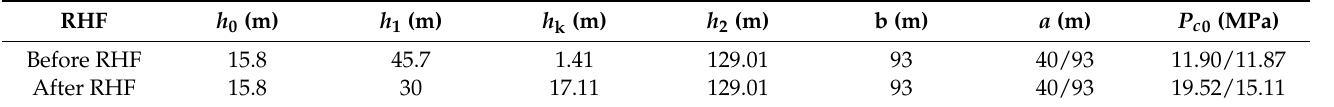
Table 3. Critical water pressure before and after RHF of panel